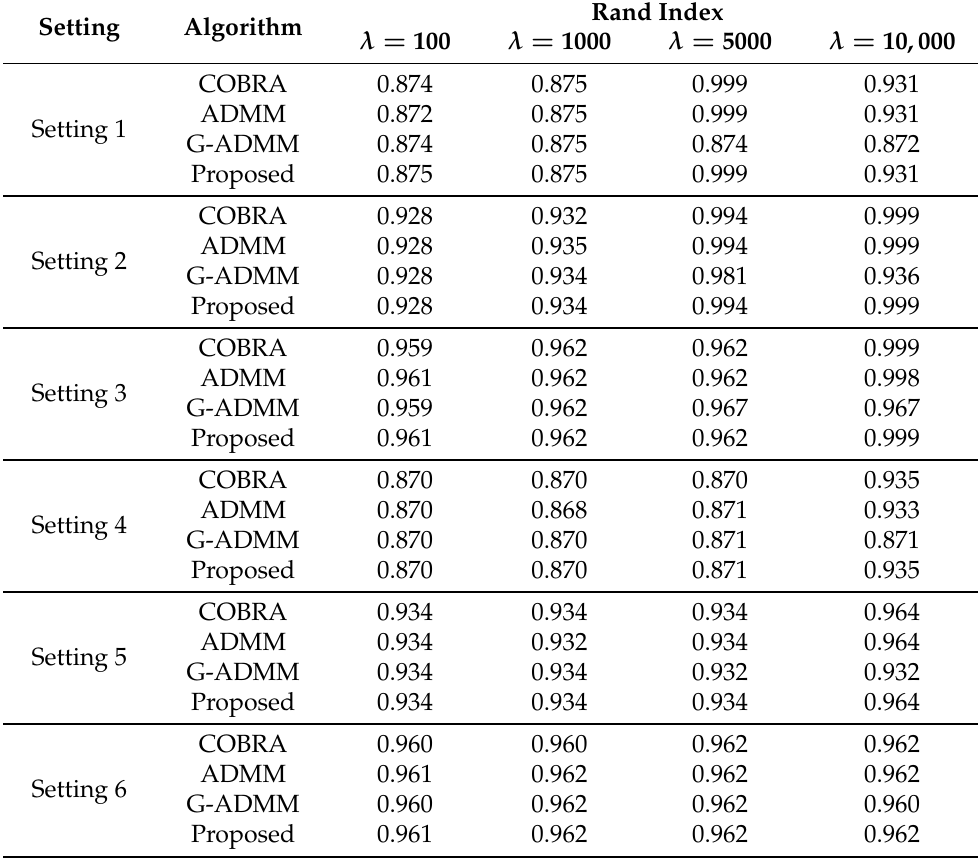
Table 2. Assessment